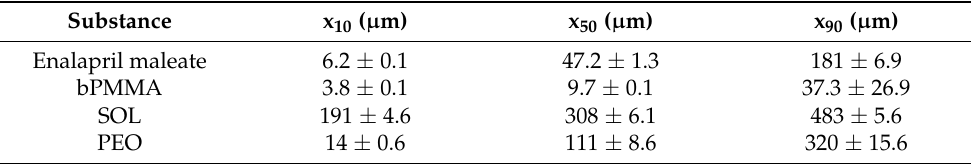
Table 6. Particle size of raw materials ( n = 3, mean ± SD).